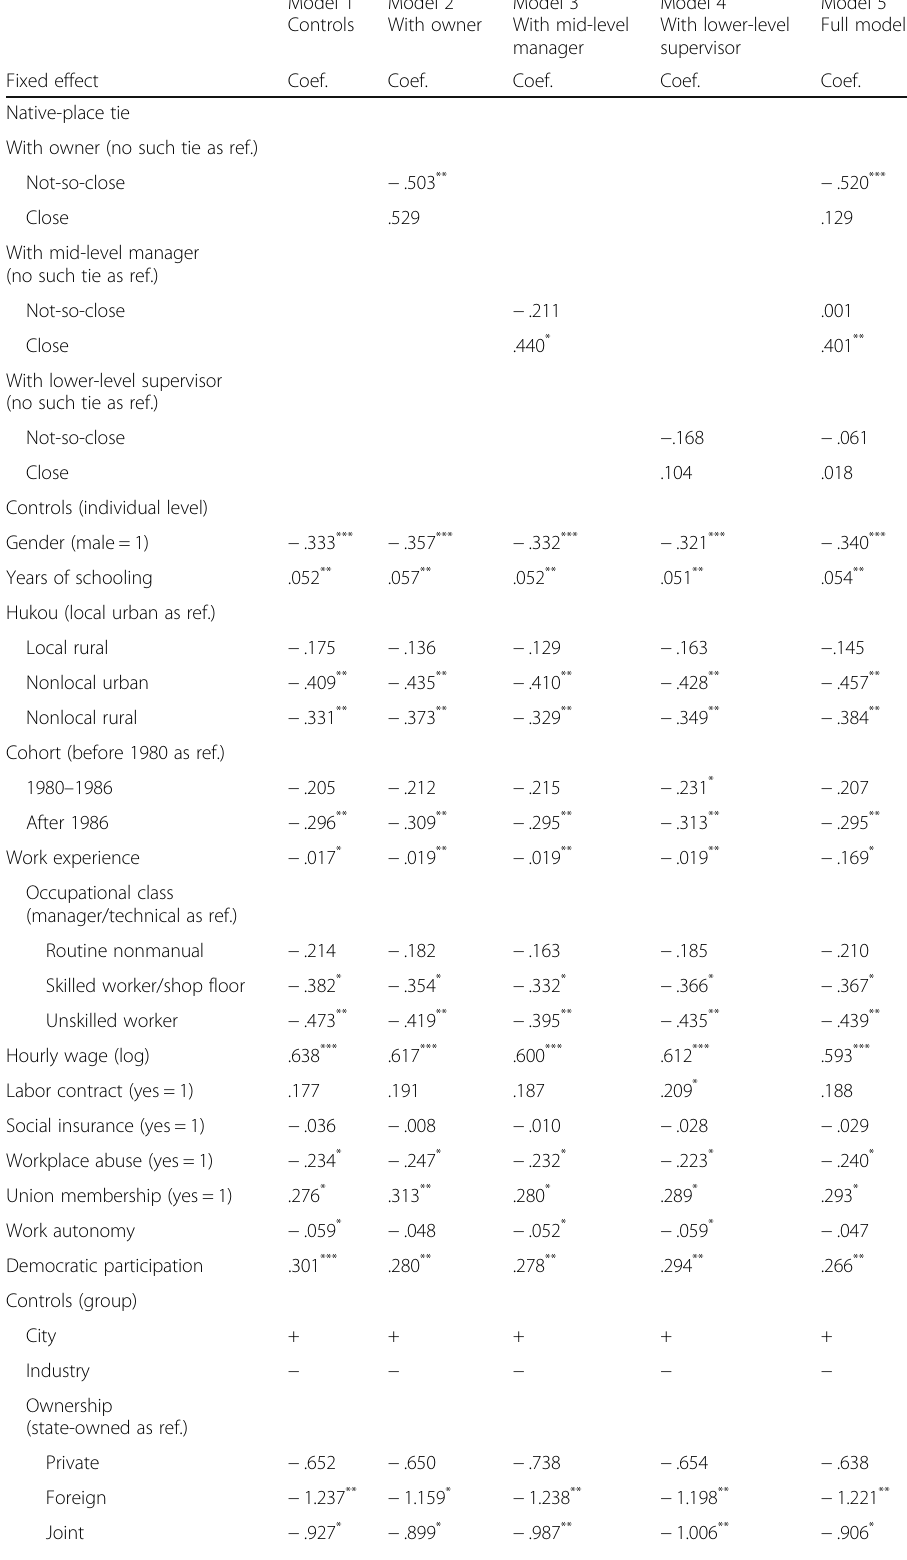
Table 4 Native-place ties and organizational commitment: a direct